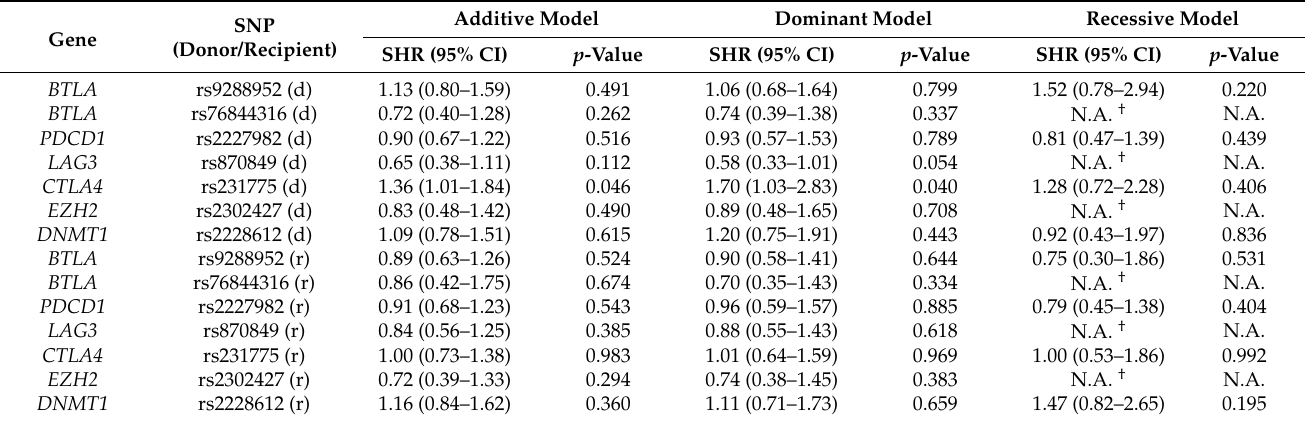
Table 2. Multivariable regression of grade 3–4 aGVHD on donor and recipient SNPs.